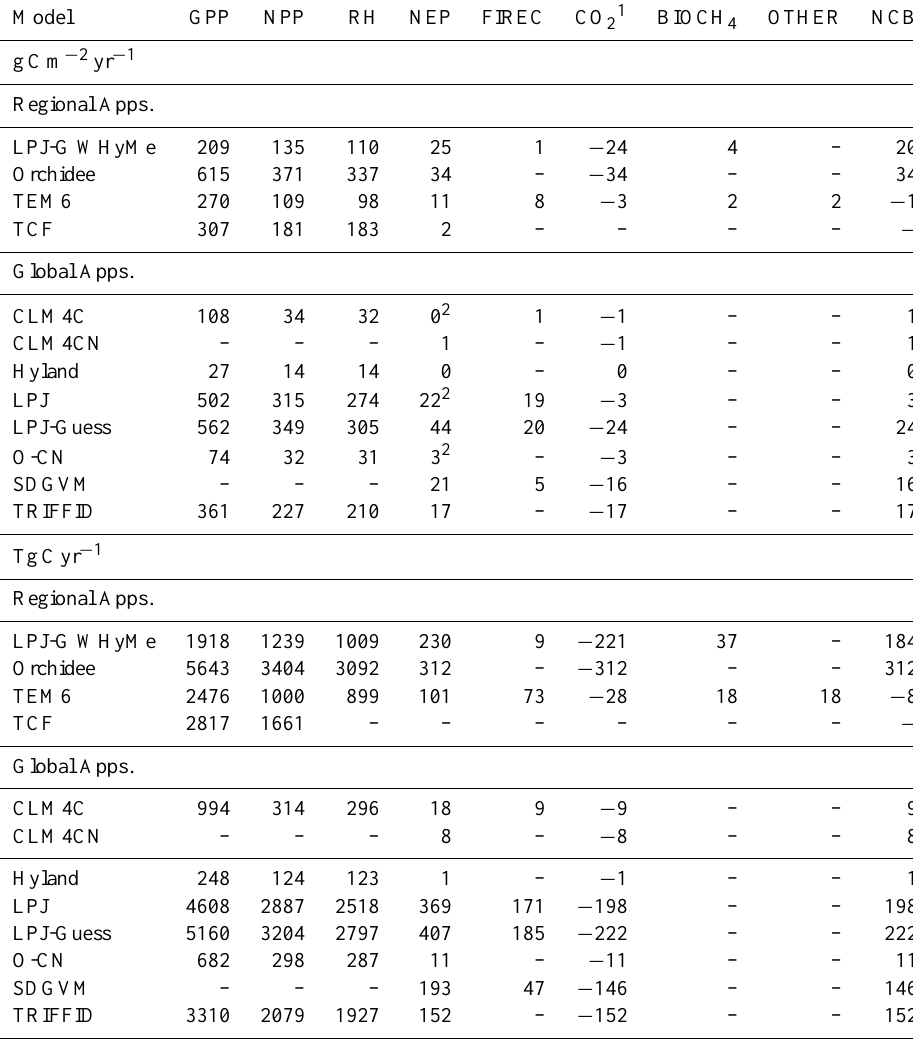
Table 6. Mean C budget of Arctic tundra simulated by process models for 2000–2006.